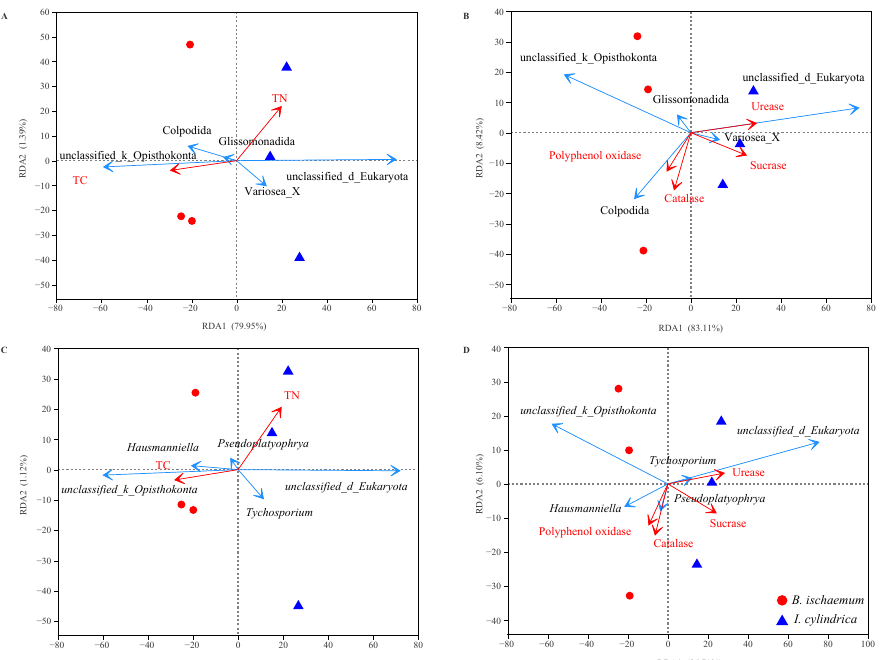
Figure 5. Redundancy analysis to determine correlations between protist communities and litter properties. Correlations between protist communities and contents of nutrient characteristics ( A ) and enzymatic activity ( B ) at an order level. Correlations between protist communities and contents of nutrient characteristics ( C ) and enzymatic activity ( D ) at the genus level. The red arrow indicates litter properties and the blue arrow indicates the dominant groups with the top 5 relative abundance.